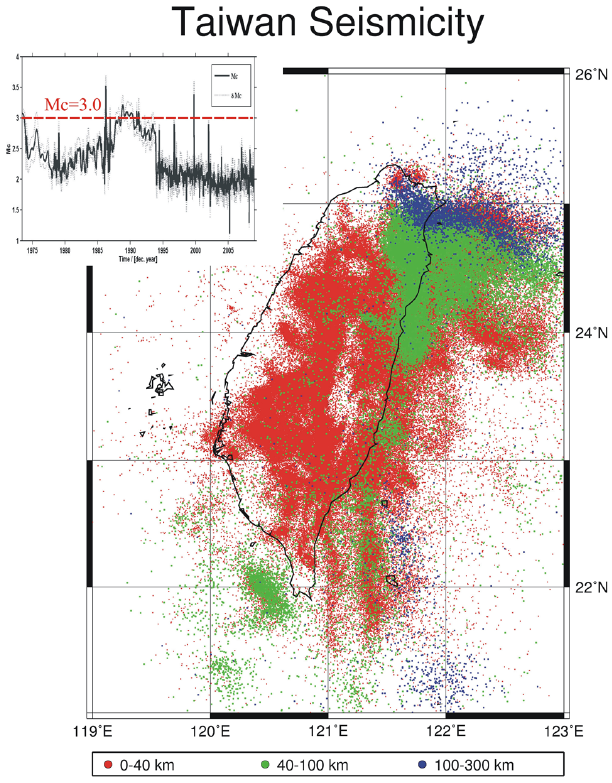
Fig. 1. Spatial distribution of earthquake epicenters with different depths highlighted by color (red dots for 0–40km, green for 40– 100km, and blue for 100–300km) and the temporal variation in magnitude of completeness ( M c ) in the Taiwan